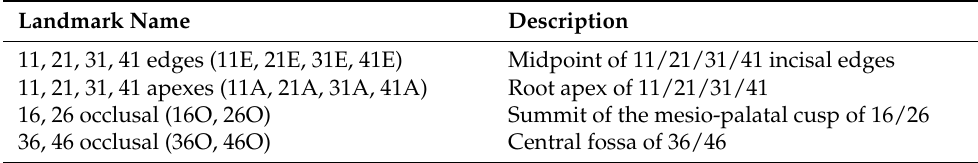
Table 2. Definition of “foraminal” landmarks localized in our study (L/R: Left/Right).